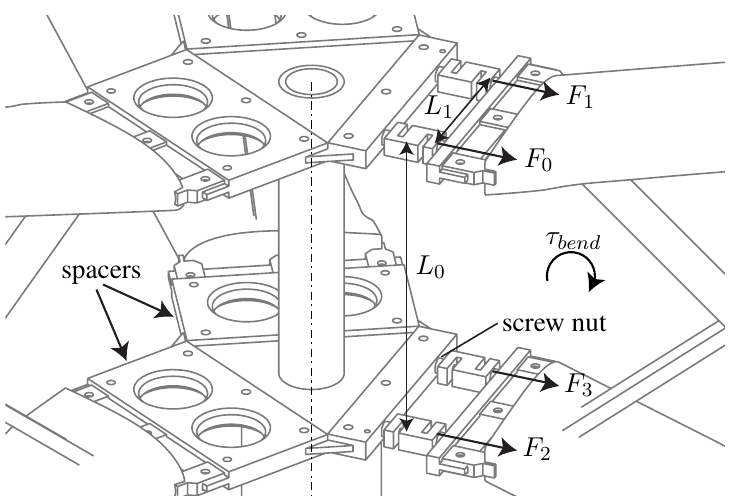
is defined as bend